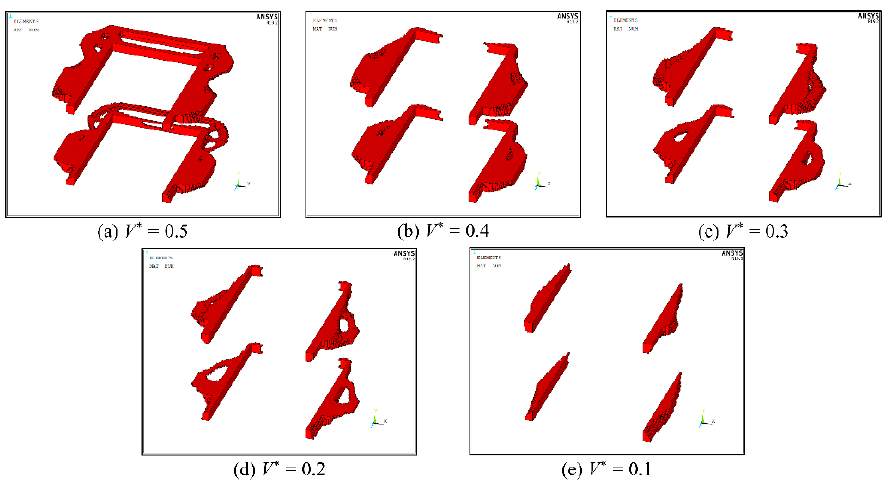
Figure 10. Optimal stiffener topology for SHS-300 × 0.5 columns with various volume fractions.